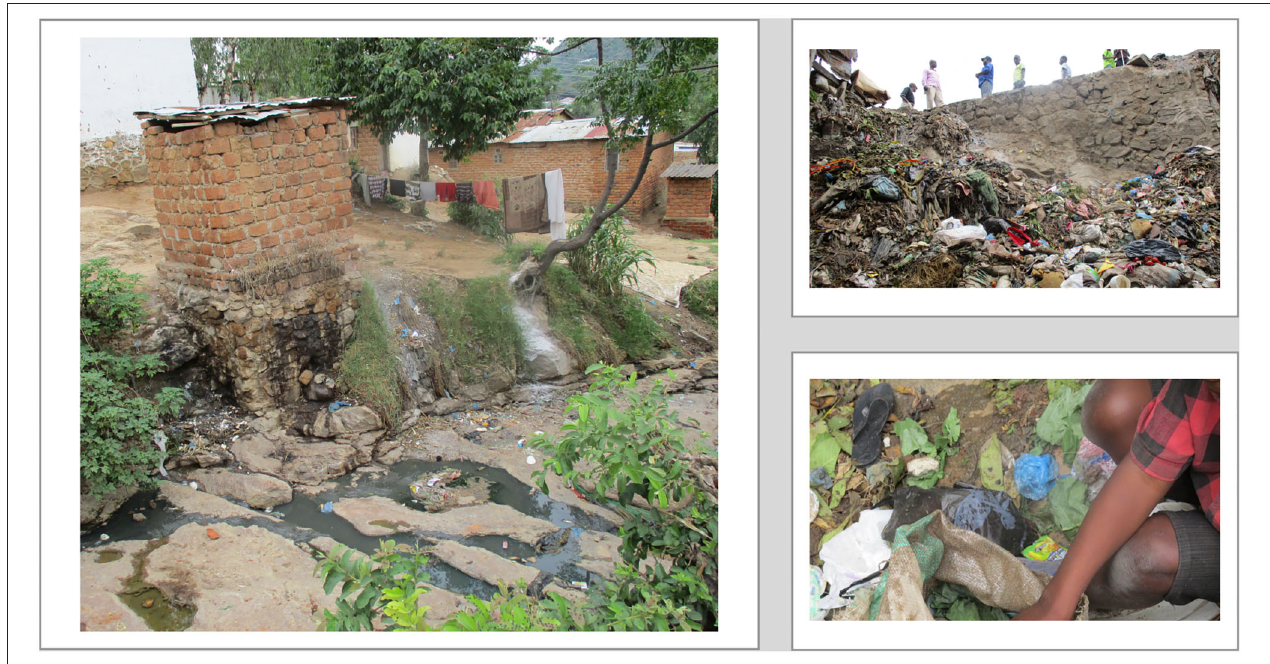
FIGURE 2 | Selected photos captured by DST